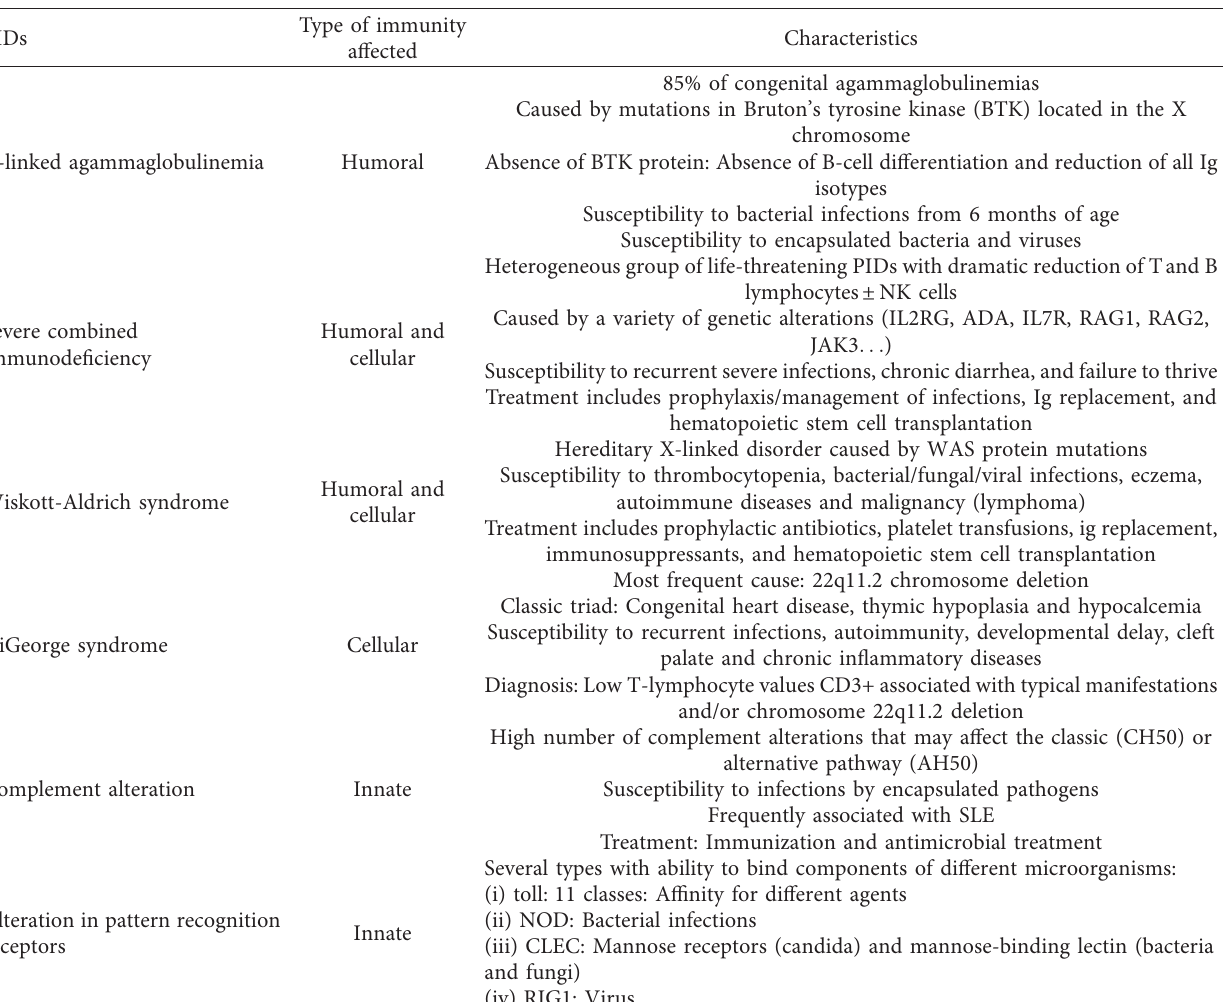
Table 5: Rare primary immunodeficiencies and their characteristics.